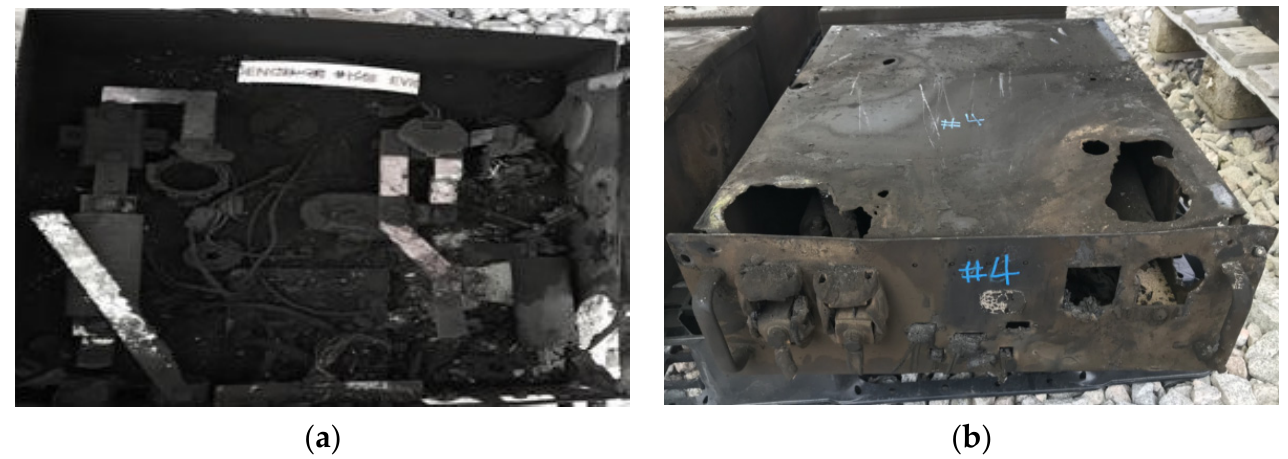
Figure 1. Fire accident cases caused by external short circuits. ( a ) Damage of DC contactor. ( b ) Burn- ing of battery control unit.